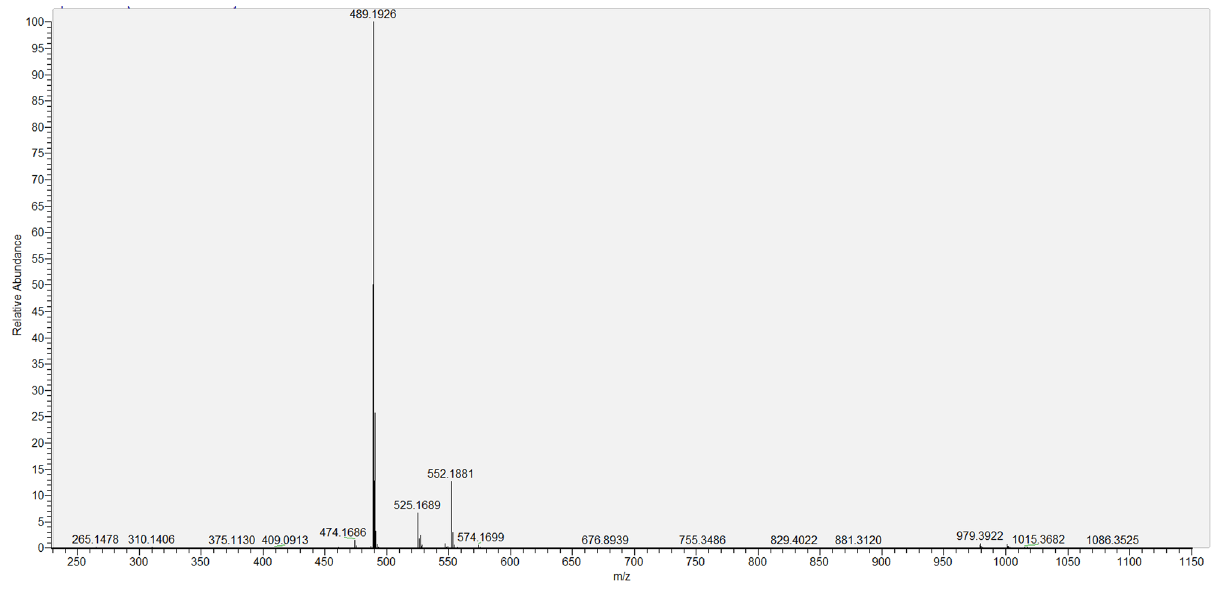
Figure 8. HRESIMS of Sildenafil N-oxide in the negative mode.